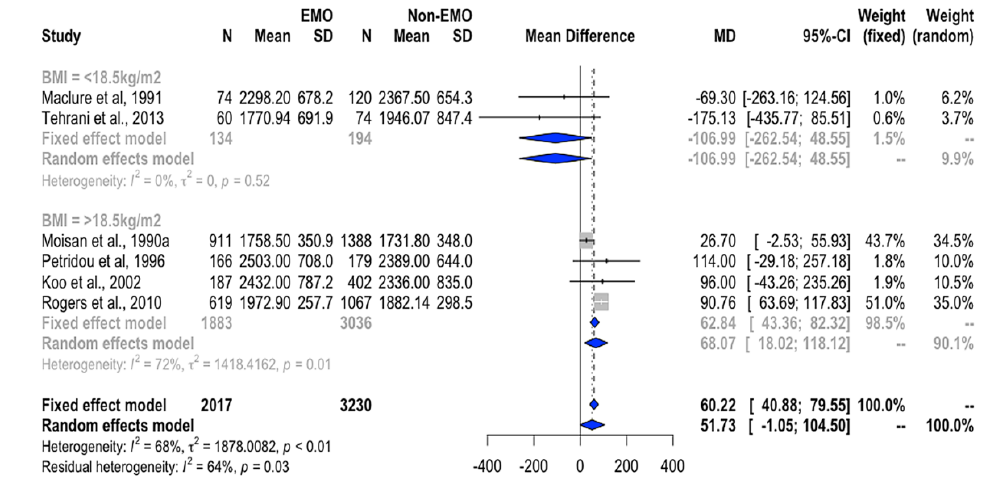
Figure 3. Risk ratio of menarche according to total EI ( a ) and protein intake ( b ) among EMO and NEMO girls. Definition of abbreviation : EI, energy intake; EMO, early menarche onset; NEMO, non- early menarche onset; RR: risk ratio. 3.4.2. Association between Protein Intake and EMO The mean difference of protein intake between girls with EMO and NEMO, as expressed by g/day or %energy, were similar. Given that BMI may be a critical factor in the meta-regression ( p <